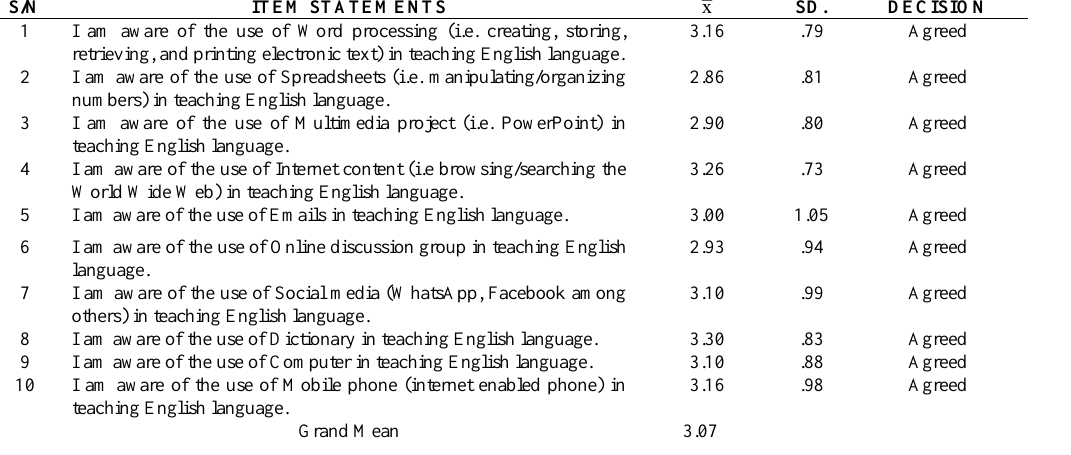
Table I: Mean and standard deviations of the teachers’ awareness of the use of technology in teaching of English language in Nsukka LGA.